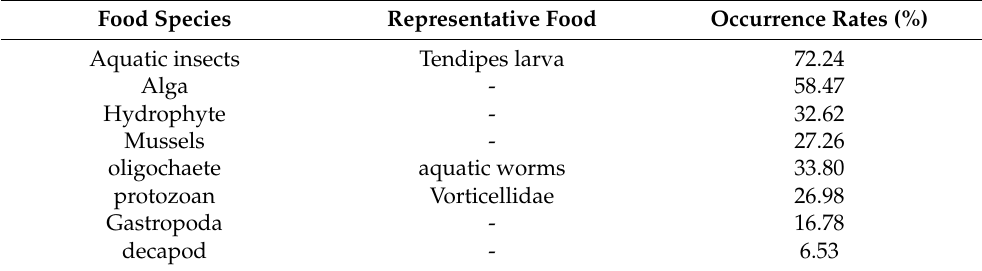
Table 2. Composition and occurrence rate of food in Hemibarbus maculatus Bleeker in the wild. Food